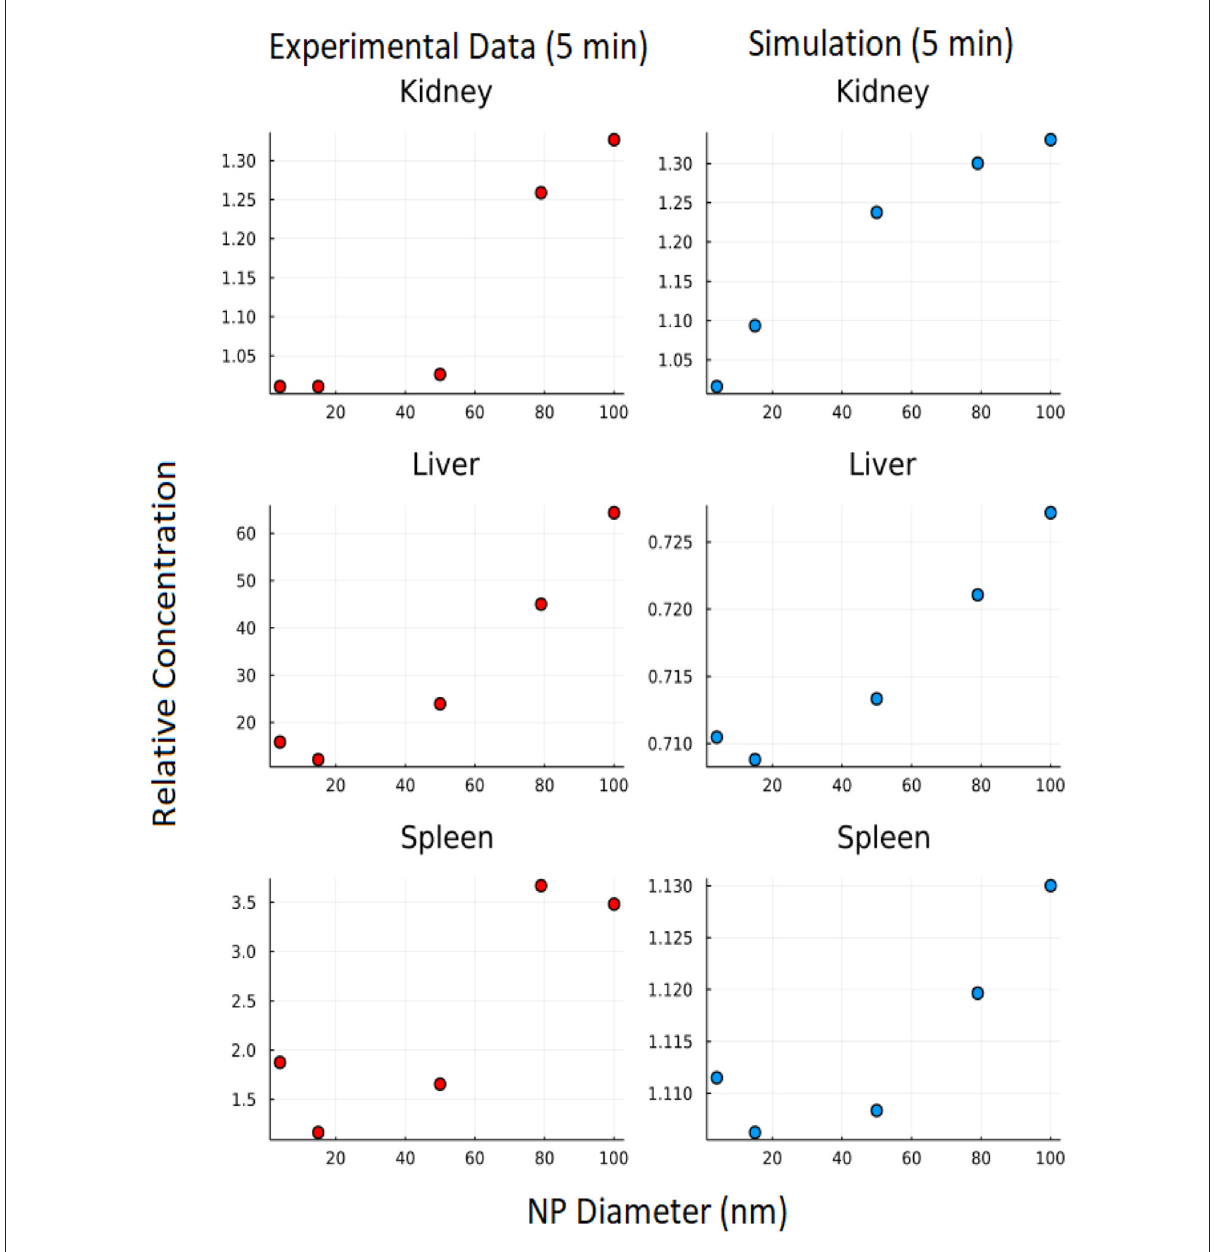
FIGURE11 Effect of NP size: Y axis represents relative concentration of nanoparticles at 5 min w.r.t initial